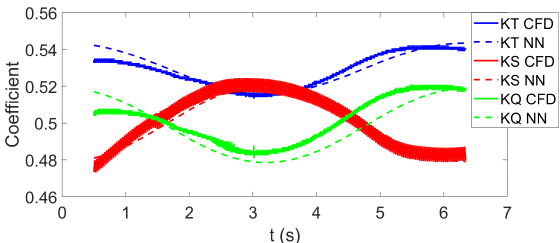
Figure 15. Behind condition Test 1 coefficients as a function of time predicted by neural network.